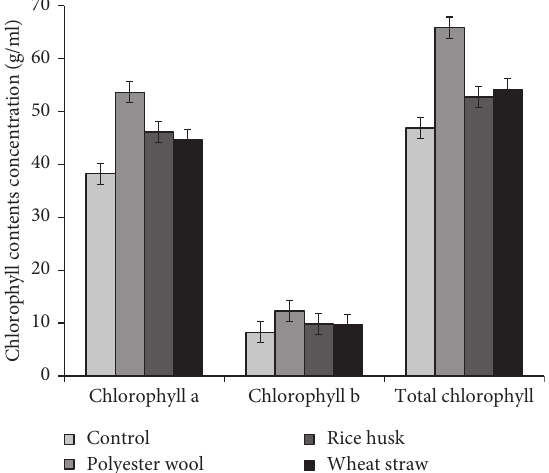
Figure 2: Effect of different growth substrates on chlorophyll contents concentration (g/ml) of strawberry cv. Chandler. Vertical bars indicate standard error of means ( ± SEM) for three